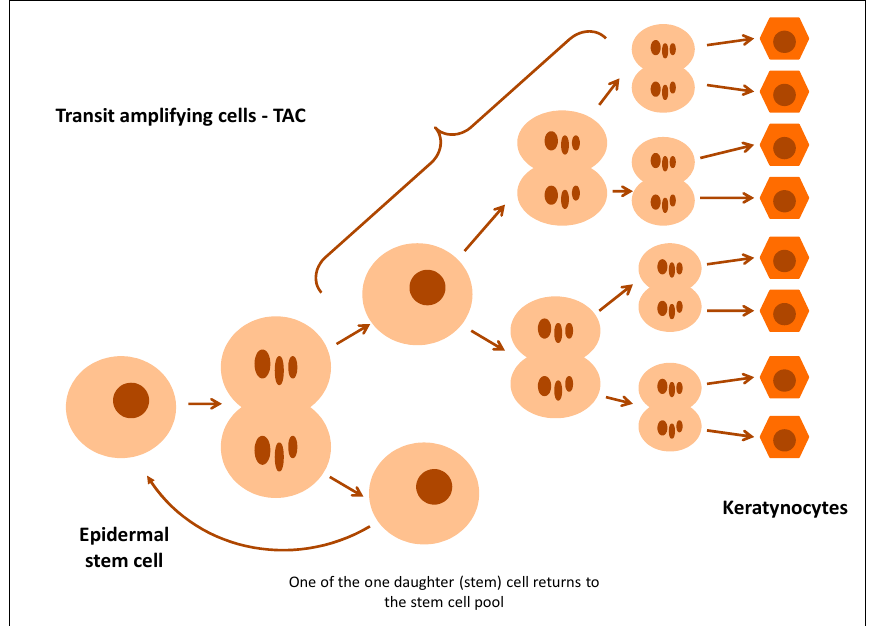
Figure 2. Regeneration of epidermis and the role of transit-amplifying cells.